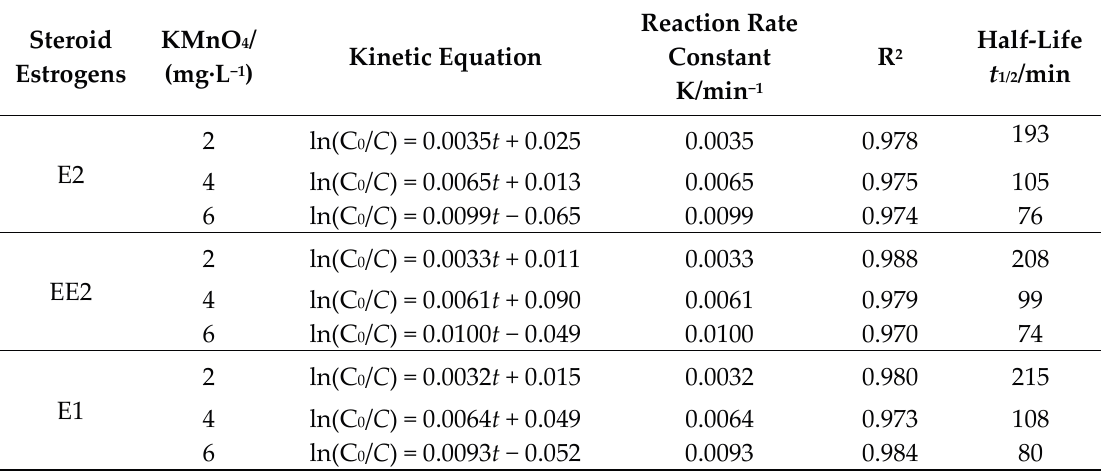
Table 1. Parameters of the kinetic model of degradation of SEs under single potassium permanganate treatment with different